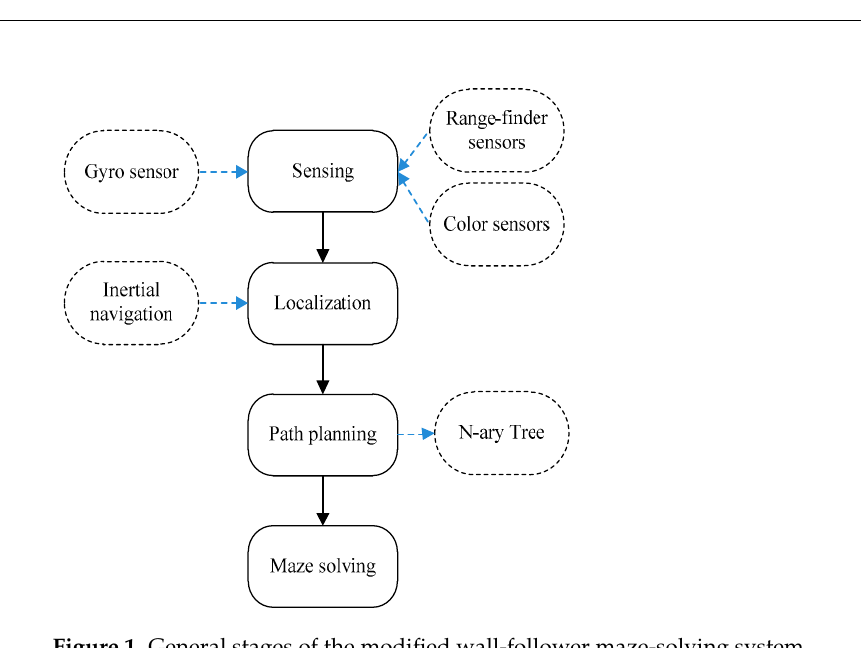
Figure 1. General stages of the modified wall-follower maze-solving system.